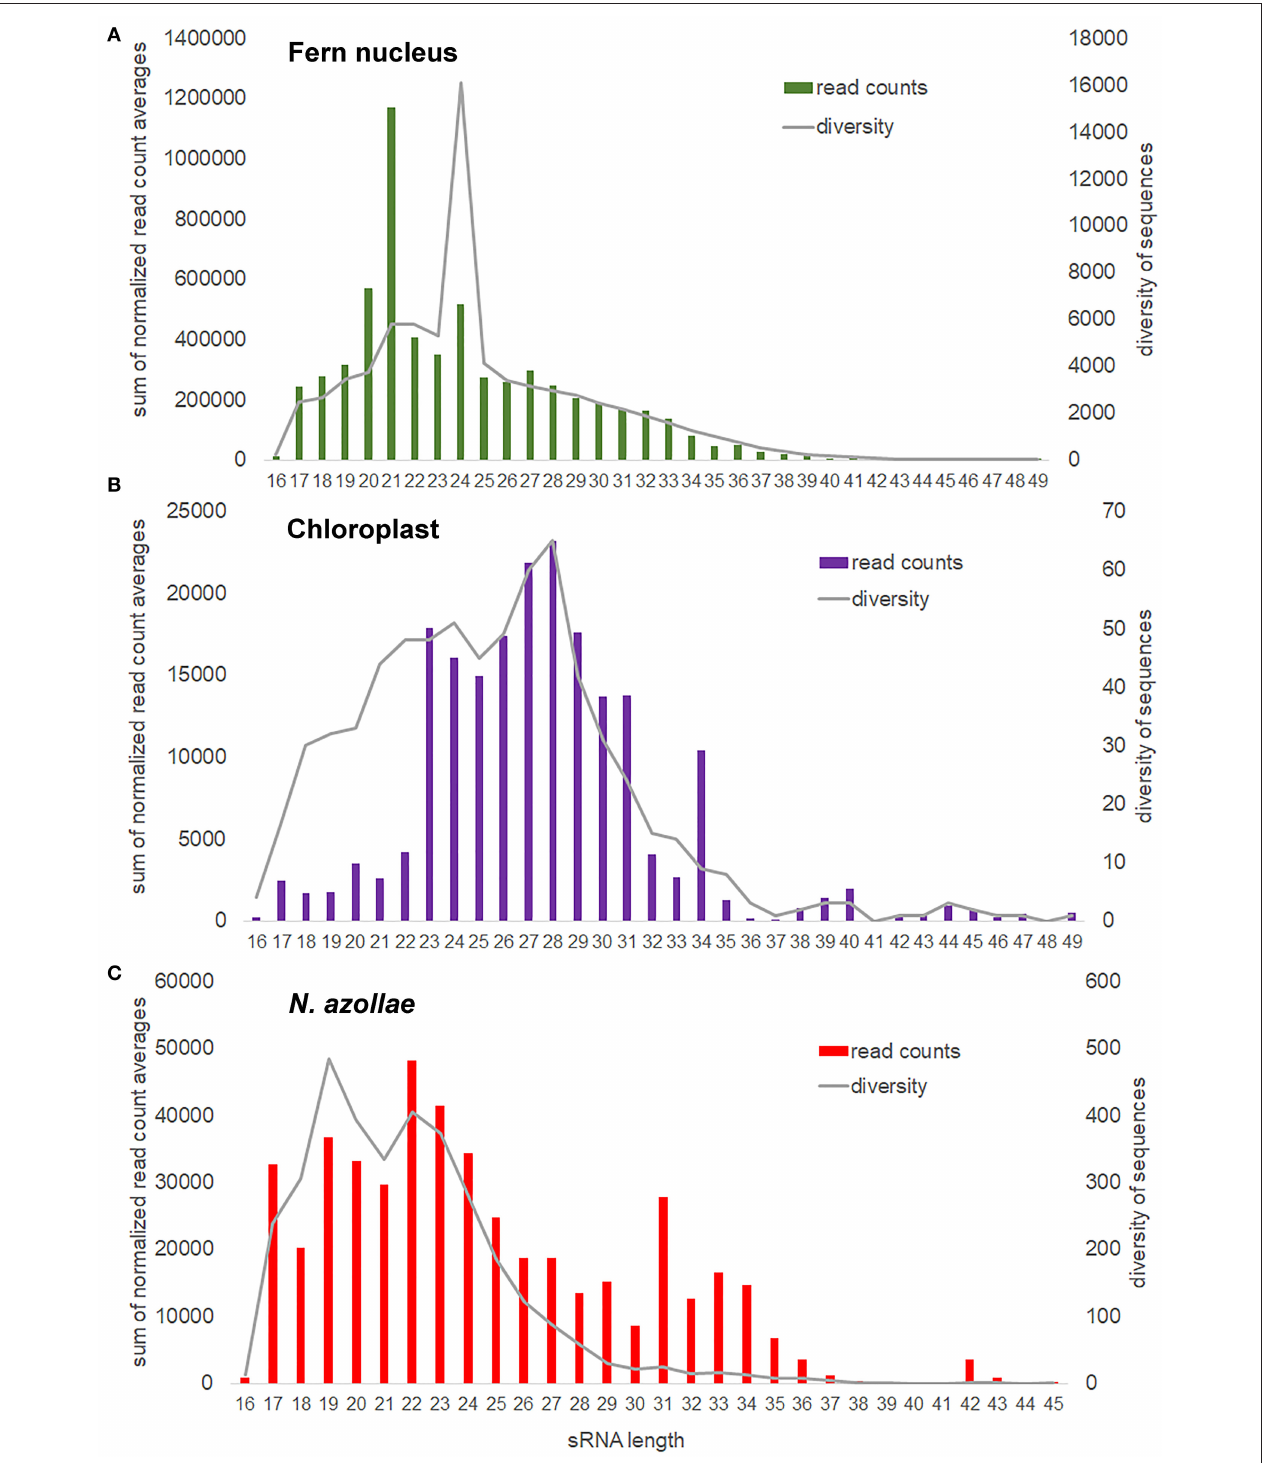
FIGURE 5 | Small RNA (sRNA) size distribution and sequence diversity for each size from the genomes in the A. filiculoides symbiosis. sRNA reads were mapped with zero mismatches, no overhang, to the concatenated genomes; bam2fasta was then used to extract sRNA sequences aligned per genome, the obtained fasta files were then collapsed to compute read counts for each sRNA, the obtained lists were then joined to a read count matrix imposing at least one read per sRNA in each of the three replicate sample types: f (FR), t (TL), and fn (FR and nitrogen in the medium). sRNA counts were then normalized to the total read counts per sample for